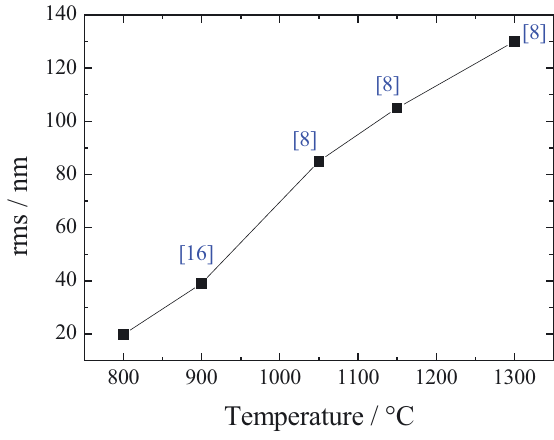
Figure 5. Scanning electron micrograph image of the surface of the Figure 7. Surface roughness (rms) dependency on oxidation tem- NiO layer on Ni tape prepared at 1300°C under air. peratures. Numbers in brackets refer to literature